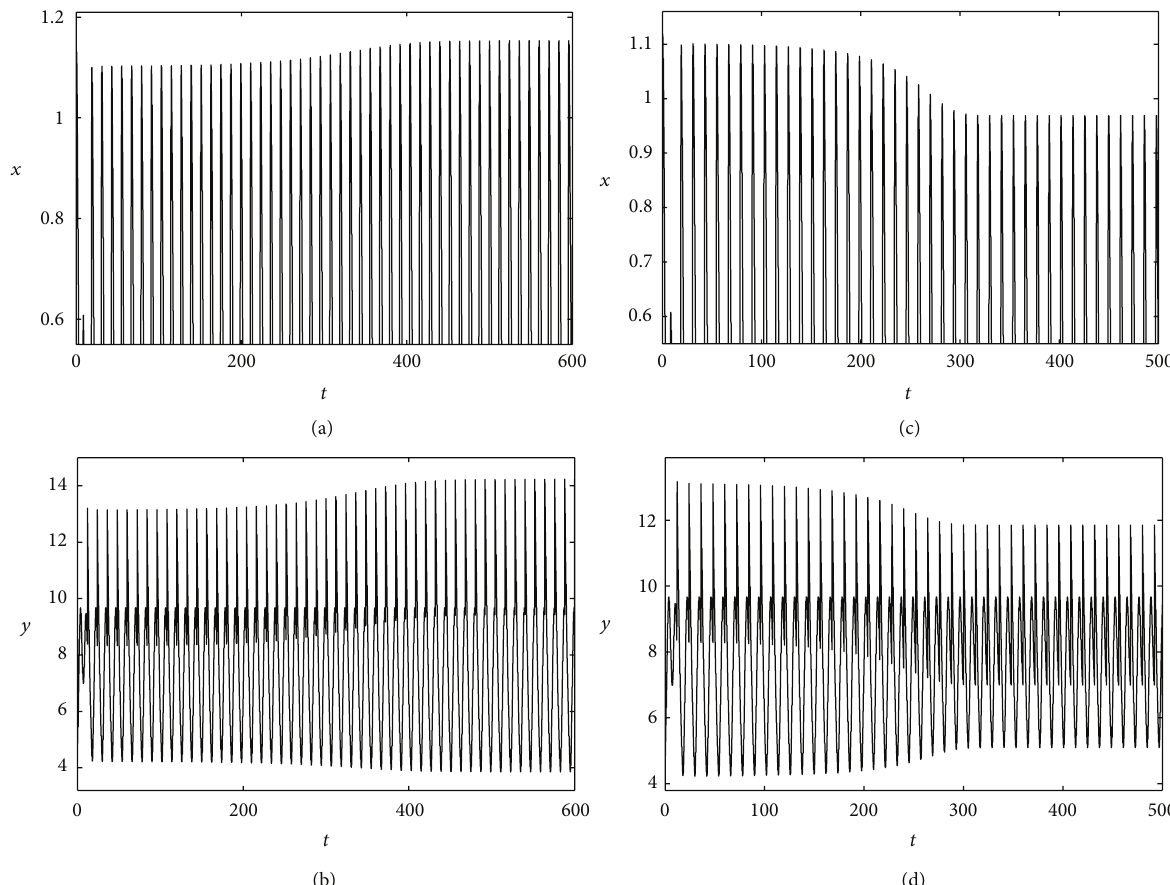
Figure 7: Attractors switch-like behaviors of model (24) with initial conditions from left to right are (𝑥 0 , 𝑦 0 ) = (0.99, 4.4), (0.95, 4.45) . The other parameters are identical to those in Figure 6.